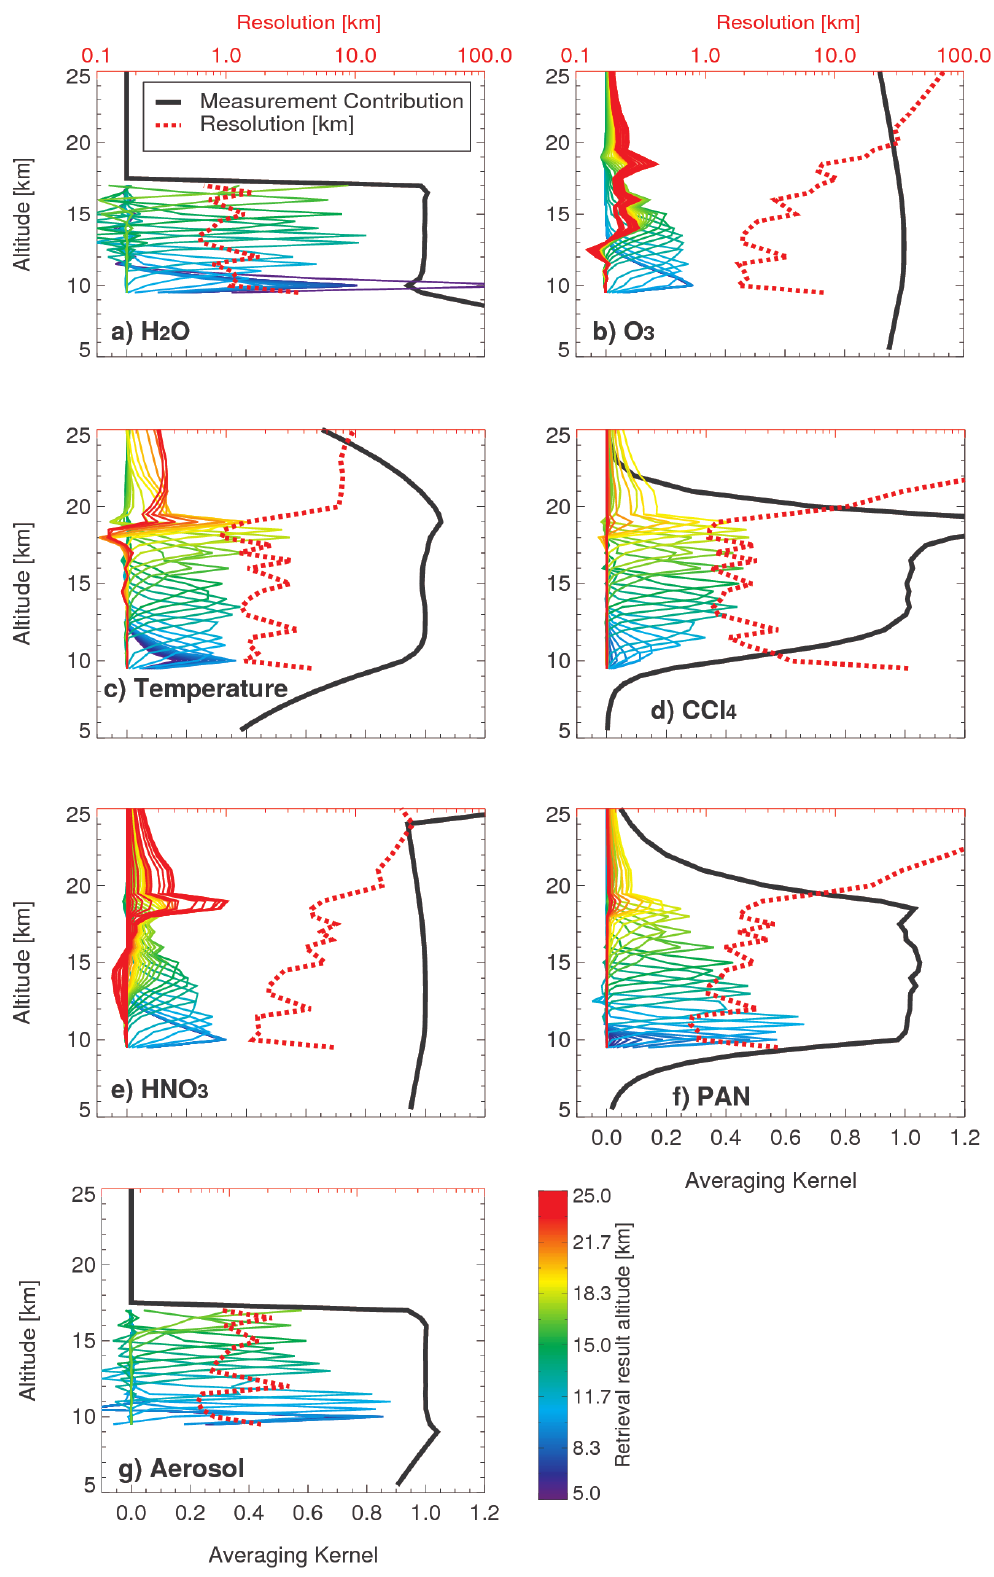
Fig. 6. Averaging kernel matrix, measurement contribution and resolution for H 2 O, O 3 , temperature, CCL 4 , HNO 3 , PAN, and aerosol extinction for profile 87 (forward spectra), flight